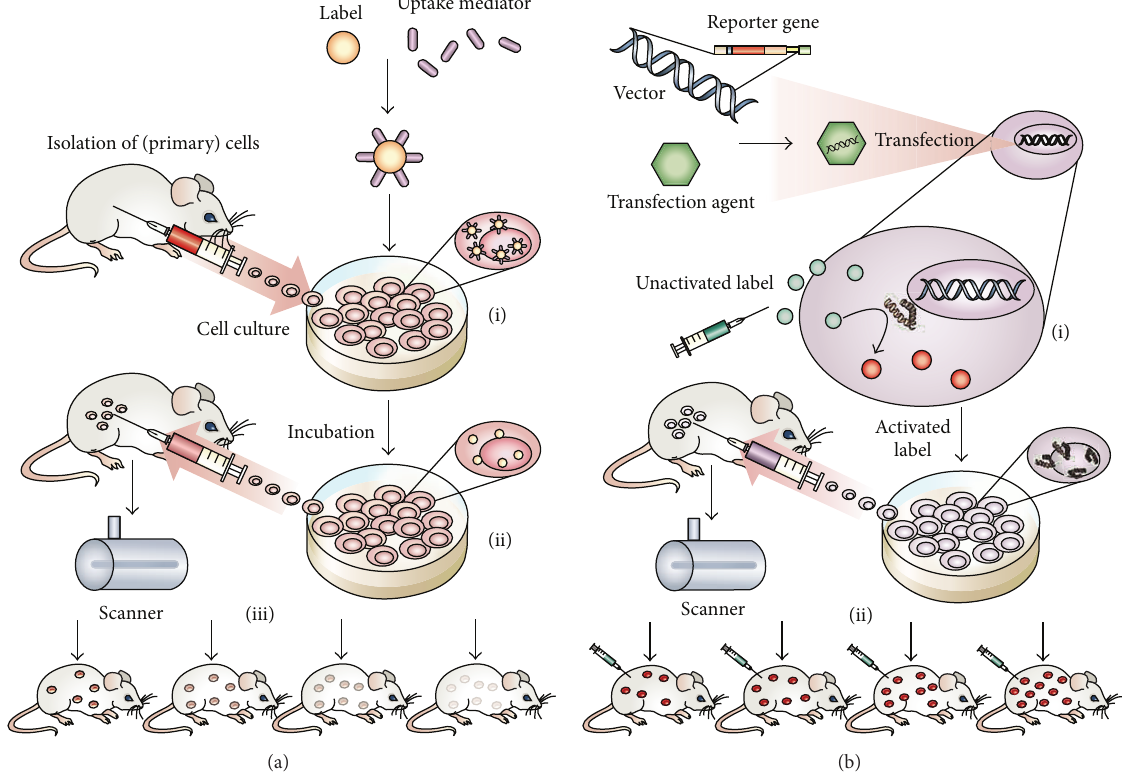
Figure 2: Labeling approaches used in SCT. (a) Direct labeling combines ((a)-(i)) cells and contrast agent and may use a transfection agent to increase the amount of agent that crosses the cell membrane. ((a)-(ii)) The labeled cells are selected from primary cells and are then injected into the target area. ((a)-(iii)) Because the label diffuses as the cells divide, contrast signal will decrease as time passed. (b) In indirect labeling, ((b)-(i)) the cells’ genome is modified by reporter gene that encodes for receptors, fluorescent proteins, or enzymes. Except for fluorescent reporter protein, the reporter gene usually does not generate contrast signal itself, but is responsible for the activation of a contrast agent that is added at the time of imaging. ((b)-(ii)) Unlike direct labeling, constitutively expressing genes gene will be copied to daughter cells and the expanded cells can be imaged as well. Reproduced courtesy of Nature Publishing Group